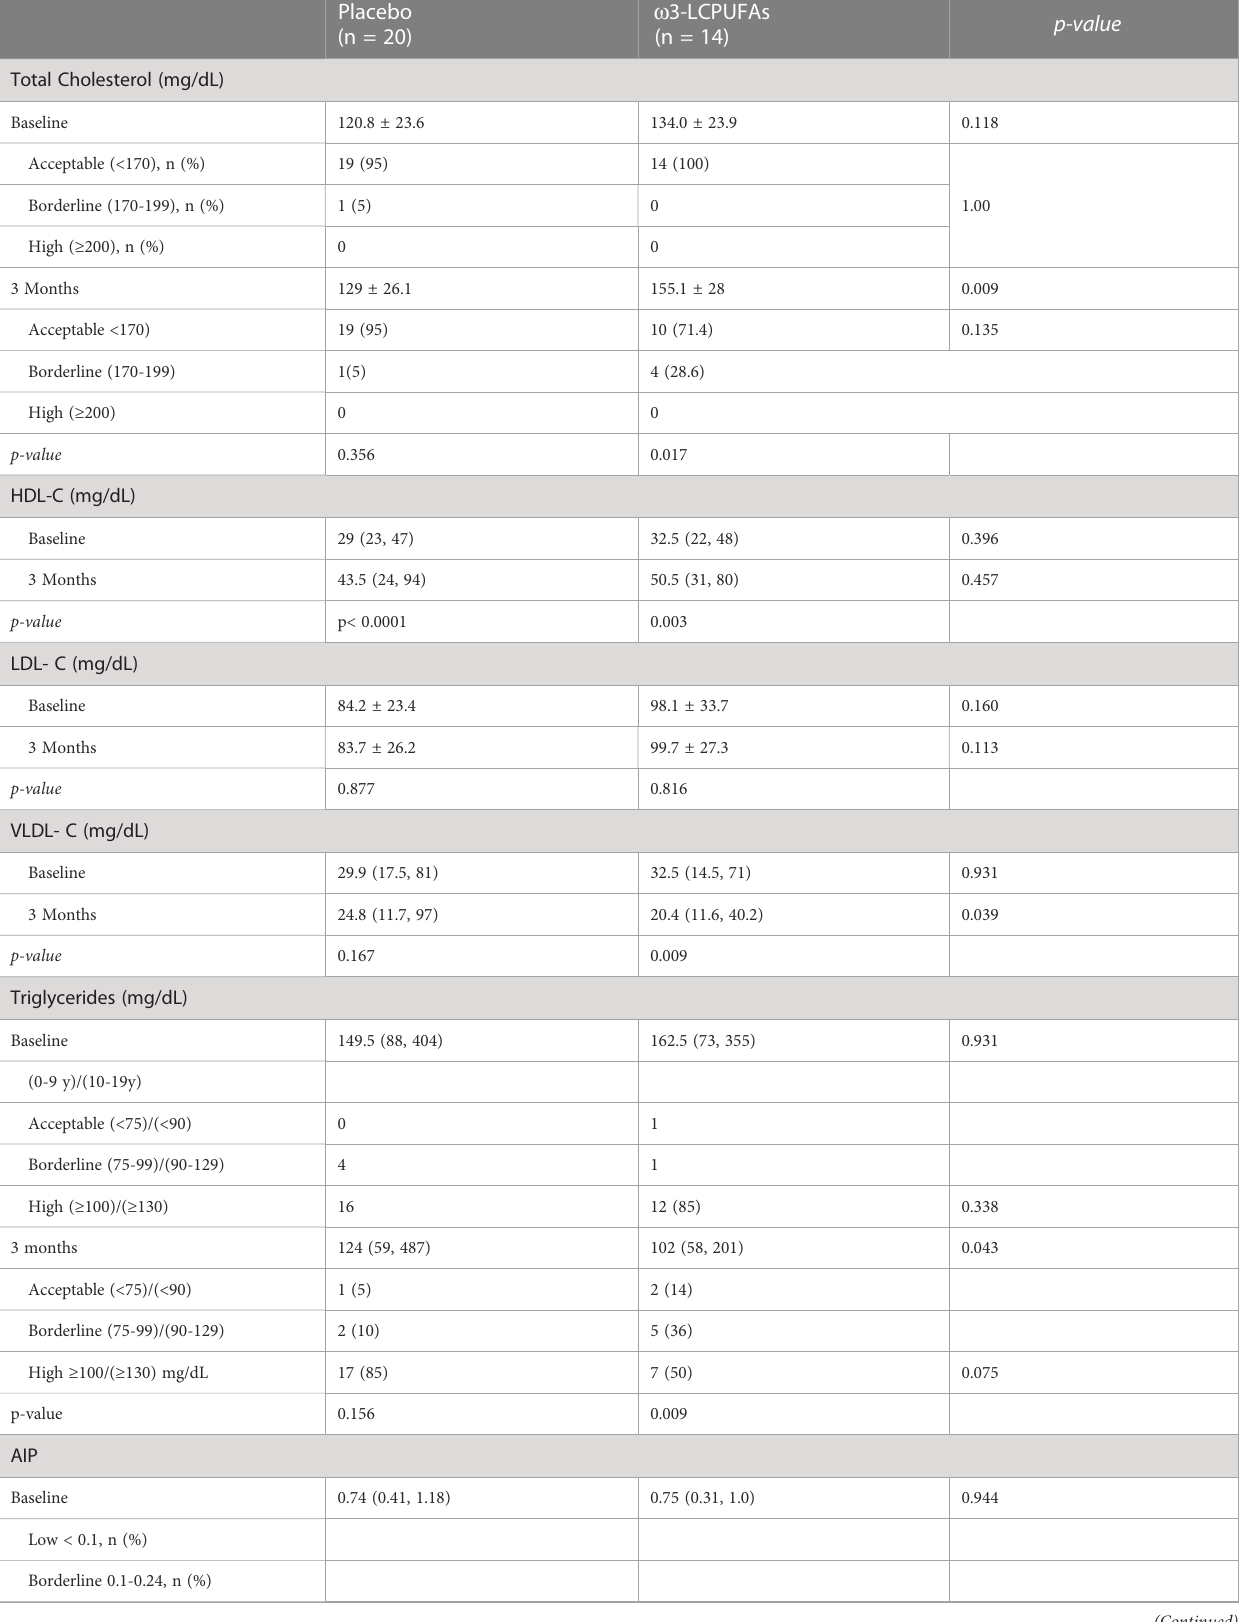
TABLE 2 Blood Lipid pro fi le at baseline and 3 months of intervention in children with acute lymphoblastic